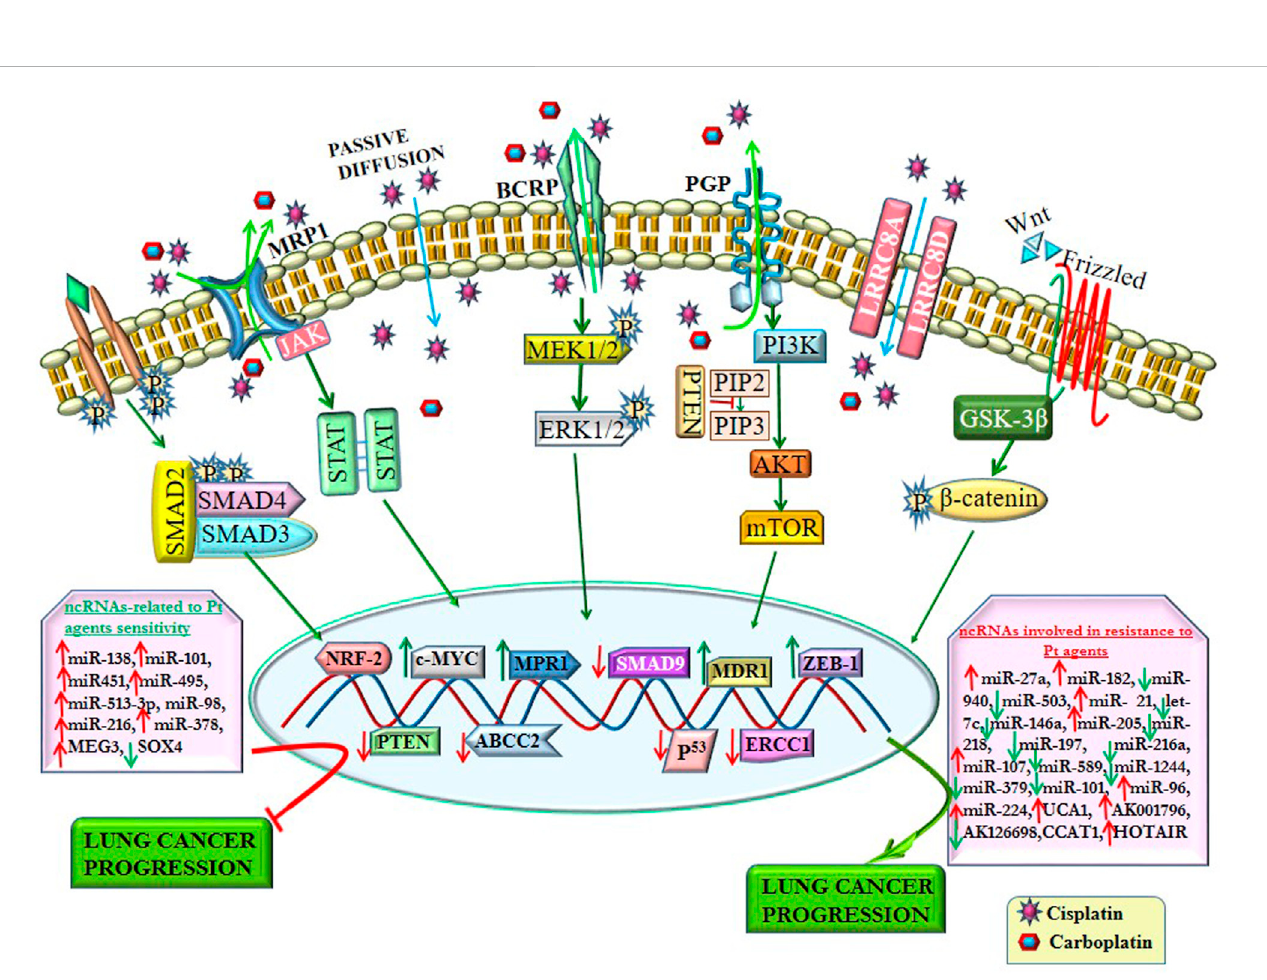
FIGURE 3 ncRNAs regulate resistance to platinum-based agents by altering signaling pathways and their related transcription factors. ncRNAs alter the drug ef fl ux transporters (P-gp, MRP1, and BCRP) involved in chemoresistance by regulating various signaling pathways. Some ncRNAs enhance platinum-based agent (Pt)-resistance by altering the expression of several transcription factors. In contrast, some ncRNAs reverse the sensitivity of Pt by regulating different transcription factors, thereby impeding lung cancer